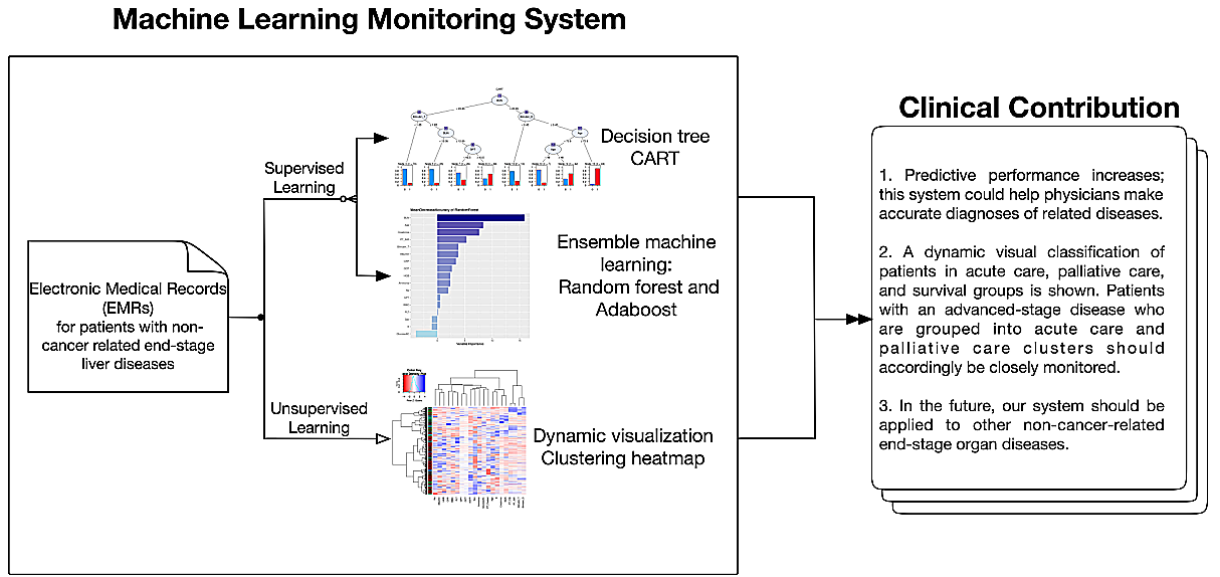
Figure 2. Flowchart depicting the structure of the machine learning medical system. CART: classification and regression tree; Adaboost: adaptive